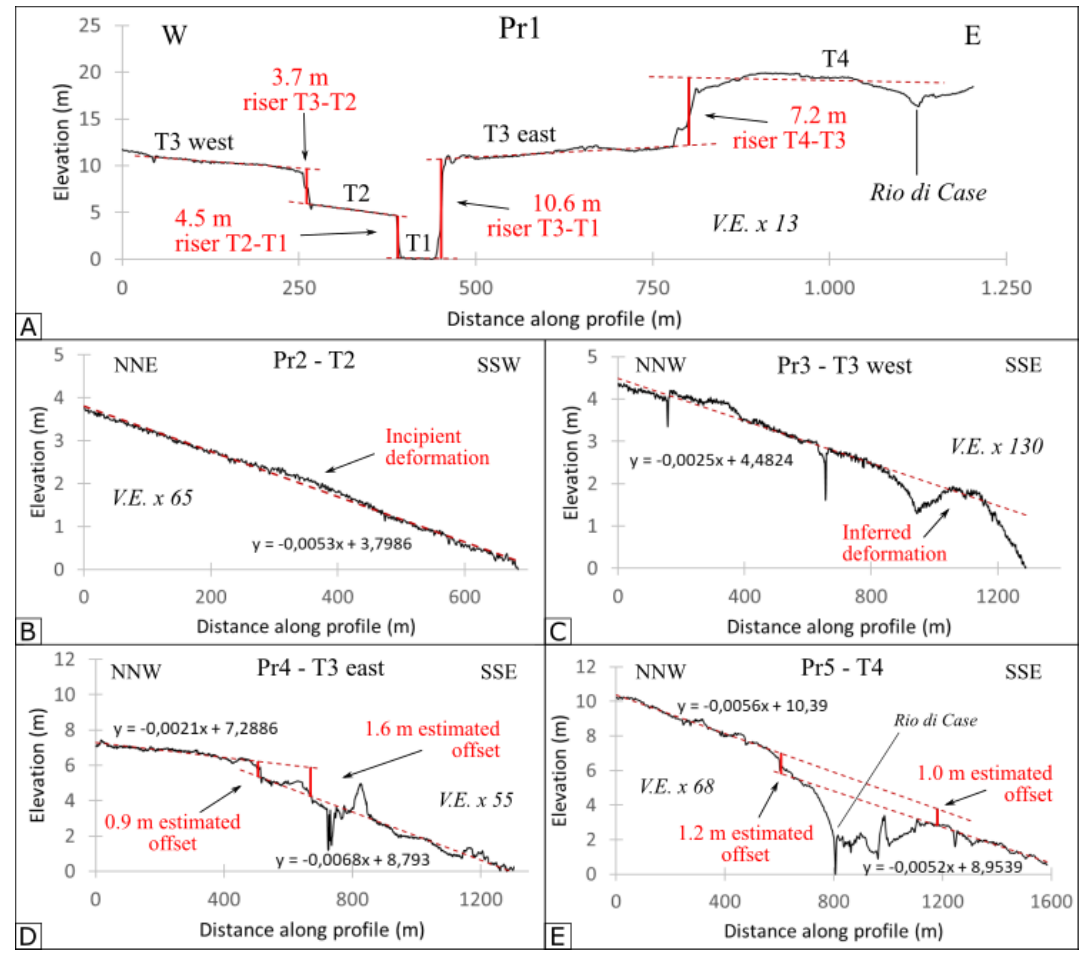
Figure 8. Topographic profiles extracted from the DEM (see Figure 7 for location of the black profiles). The black arrows highlight the points where the terrace surfaces are disturbed either by terrace risers or by scarps. The offset estimates are displayed by red vertical segments. The red dashed lines represent the slope trends of the terrace surfaces. On the y-axis, we plotted the relative elevations instead of the absolute values. “V.E.” stands for “Vertical Exaggeration”. ( A ): W-E topographic profile across the Natisone valley. ( B ): Topographic profile along the central part of river terrace T2. ( C ):